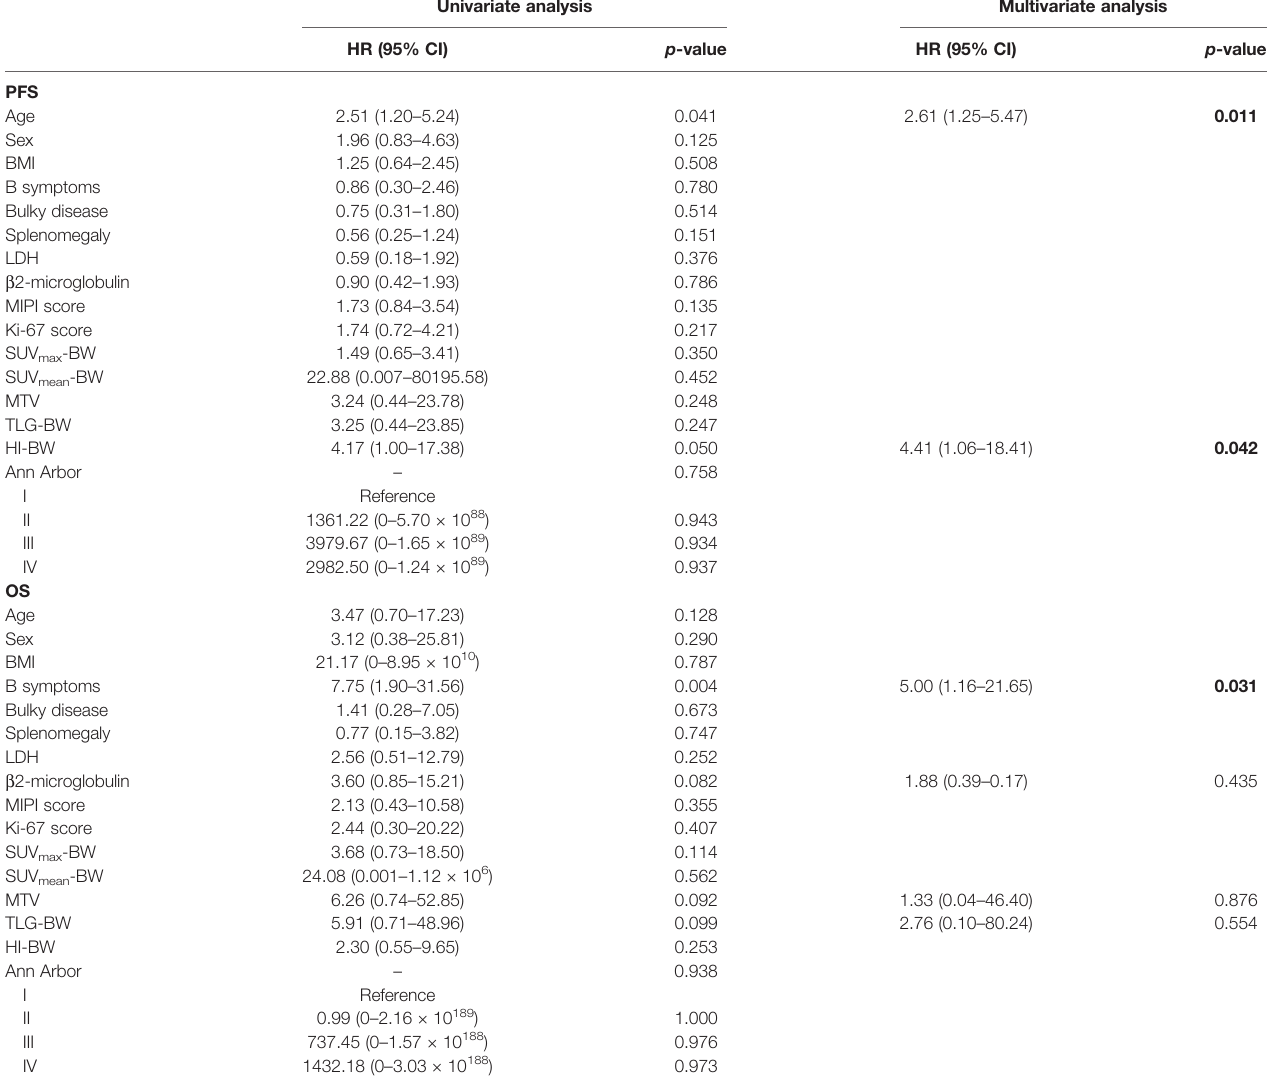
TABLE 3 | Univariate and multivariate analyses of BW-related prognostic factors in relation to PFS and OS using the Cox regression model. Univariate analysis Multivariate